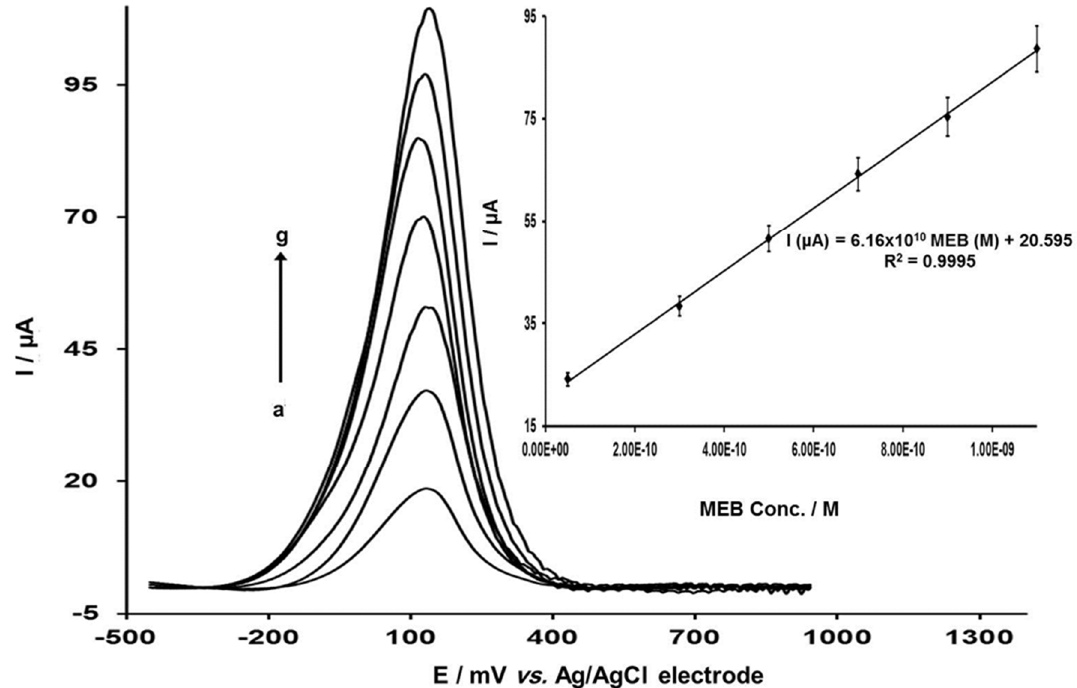
Figure 8. Typical SWAdAS voltammograms of different MEB concentrations: ( a ) residual current, ( b ) 5.00 × 10 − 11 M, ( c ) 3.00 × 10 − 10 M, ( d ) 5.00 × 10 − 10 M, ( e ) 7.00 × 10 − 10 M, ( f ) 9.00 × 10 − 10 M and ( g ) 1.10 × 10 − 9 M. Inset, calibration graph for MEB voltametric determination. Measurement conditions: 0.1 M phosphate buffer (pH ≈ 8.0) containing 0.1 M KCl at − 0.6 V accumulation potential and 60 s accumulation time using Cu 2 ONPs-C@G/PE as working electrode. Table 2. Regression data of calibration plot for MEB using Cu 2 ONPs–C@G/PE in 0.1 M phosphate buffer solutions (pH ≈ 8) containing 0.1 M KCl.